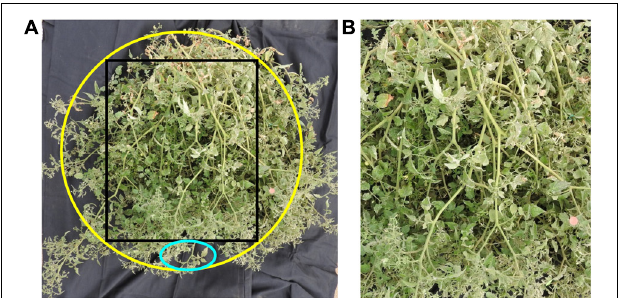
FIGURE 2 | (A) Tomato plant with black material as background. The yellow ellipse shows the approximate perimeter of the plant, while the black square shows the part of the photo analyzed in (B) . The cyan ellipse shows how areas with no plant material were excluded to correspond with the UAV-based plant delineation results. In this particular example, the studied plant had a PPC of